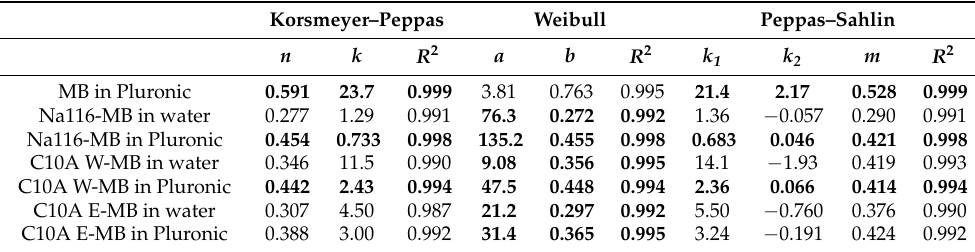
Table 4. MB release profile from the different systems studied: parameters values and R 2 adj obtained from fitting the mathematical models to experimental data. Bold numbers represent the model that best fits the experimental